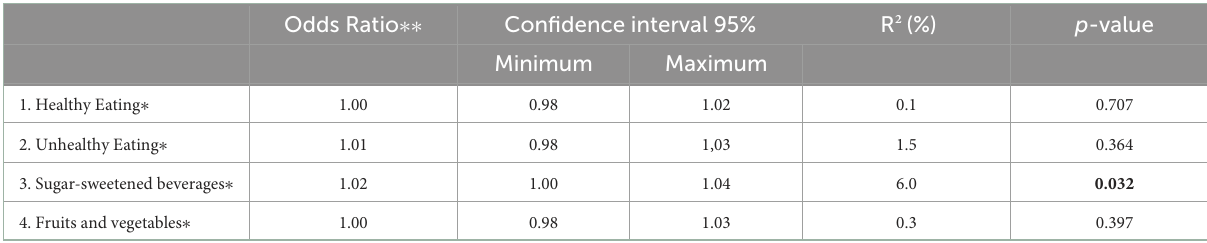
TABLE 3 Association between the consumption of food markers (outcome) and self-efficacy (independent variable) among Brazilian adolescents and young